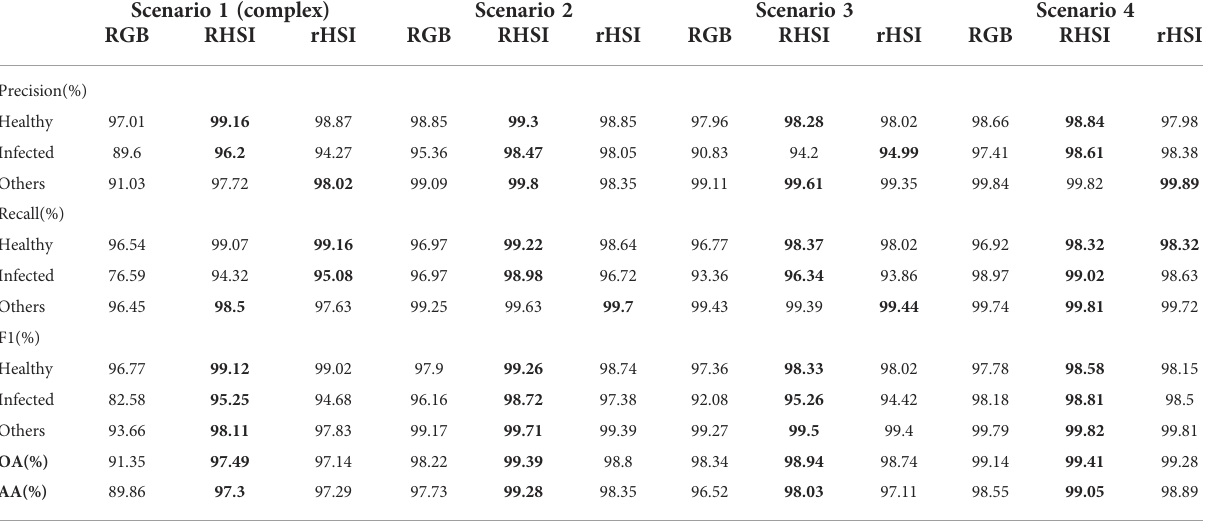
TABLE 2 Detection results of maize disease in different scenarios.